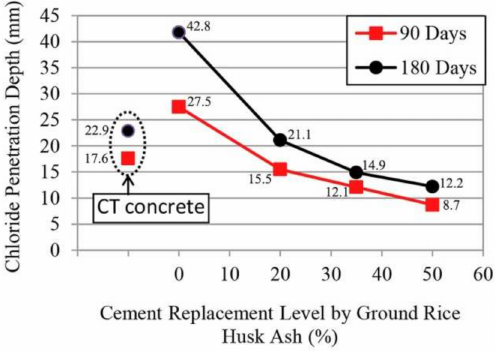
Figure 6. Relationship between the depth of chloride ion penetration in concrete and the level of rice husk ash replacement [96].